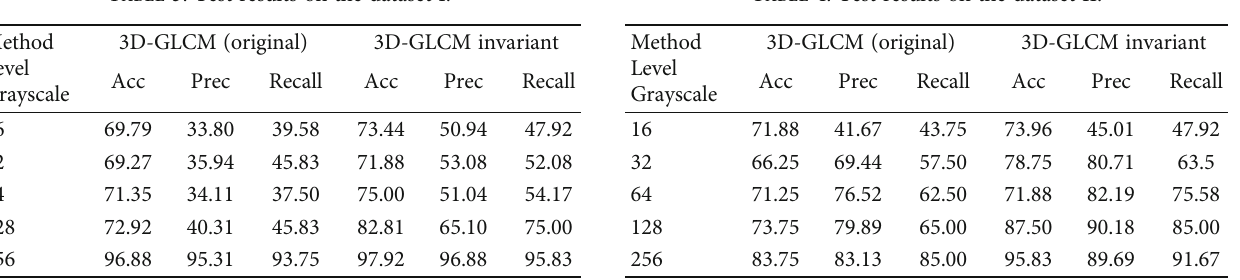
Figure 3: Iris image: (a) patients with DM; (b) patients with HC; (c) patients with DM and HC; (d) normal patient. Table 3: Test results on the dataset I. Table 4: Test results on the dataset